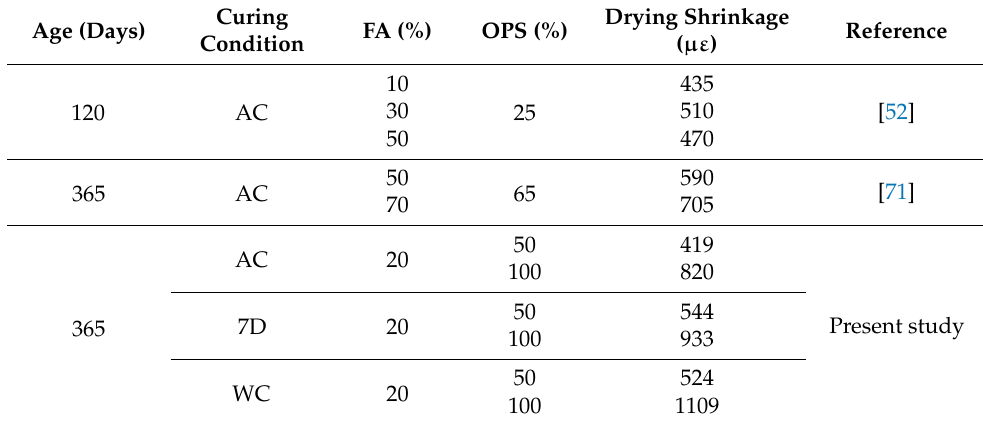
Table 10. Drying shrinkage comparisons with previous